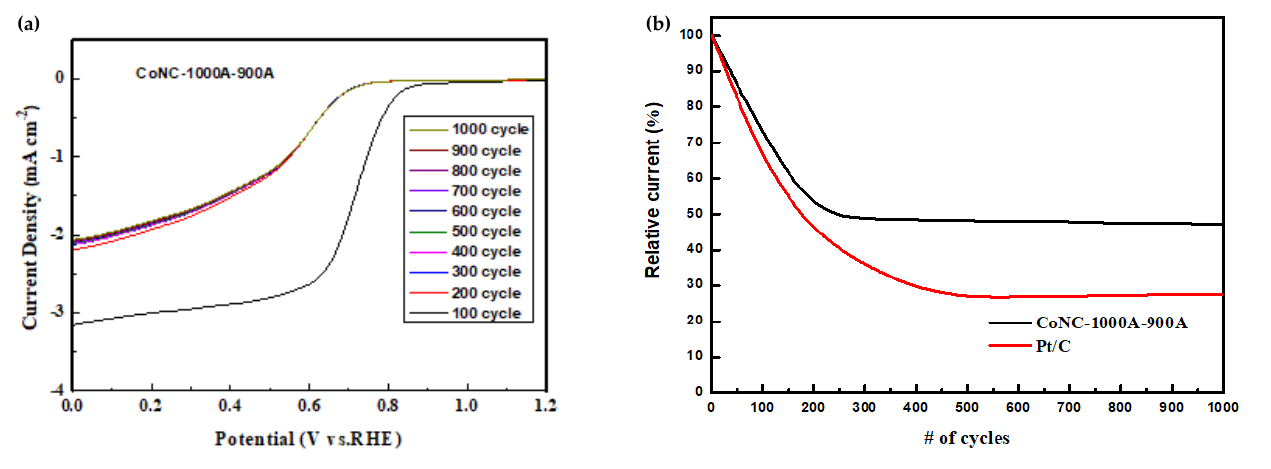
Figure 11. Durability testing of CoNC-1000A-900A and commercial Pt/C catalyst.( a ) LSV curves obtained with different numbers of cycles. ( b ) Relative current vs. number of cycles derived from ( a ).